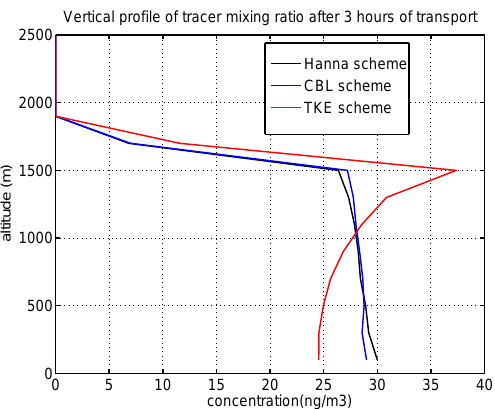
Fig. 3. Vertical profile of concentration of a tracer emitted from a point source at the surface in a convective PBL after 3h of transport. Vertical profiles from each available PBL scheme in FLEXPART- WRFv3.1 are